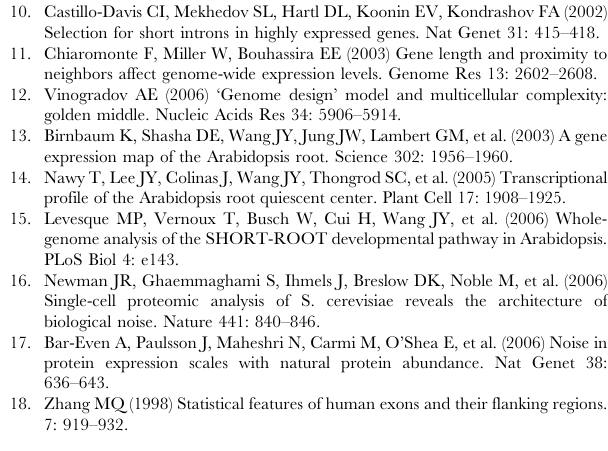
Table S1 Data file used for the